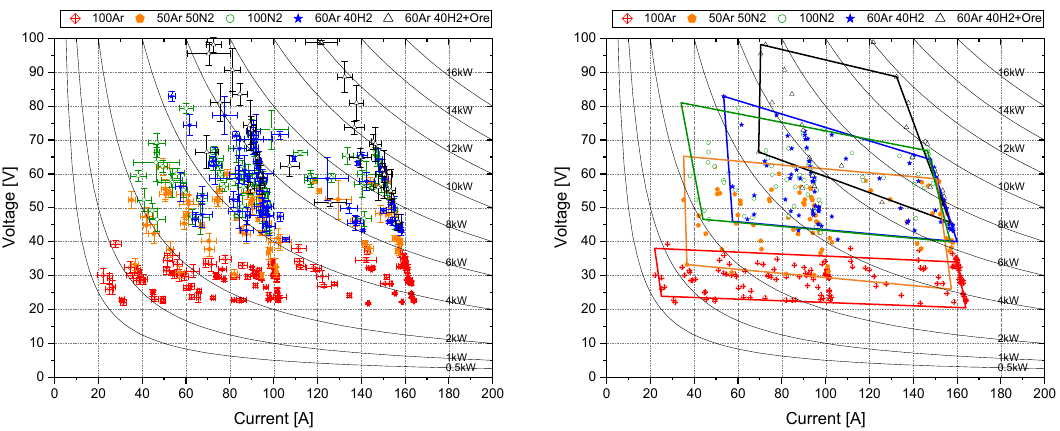
Figure 16. Arc stability fields for the variation of the gas composition and the effect of iron ore introduction via the HGE.